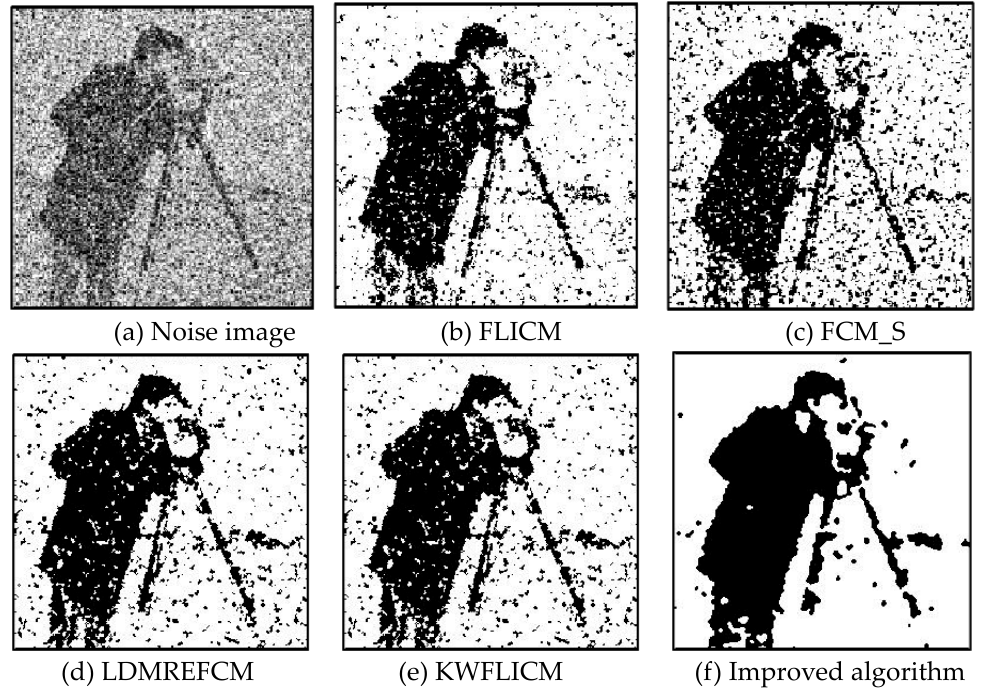
Figure 4. Gaussian noise interfering with the brain slice image ( a ) and the segmentation results ( b – f ).